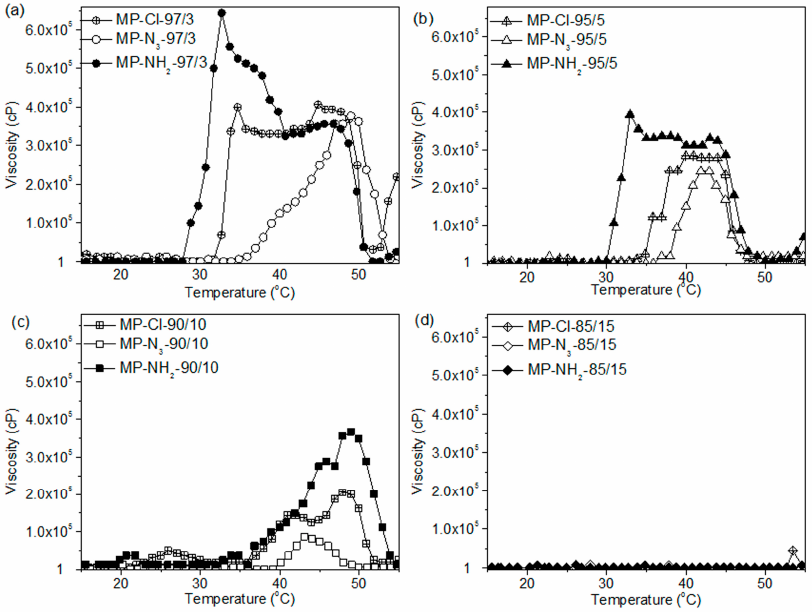
Figure 7. Viscosity-versus-temperature curves of MP-Cl, MP-N 3 , and MP-NH 2 diblock copolymer solutions with ( a ) 3, ( b ) 5, ( c ) 10, and ( d ) 15 mol % of pendant groups.